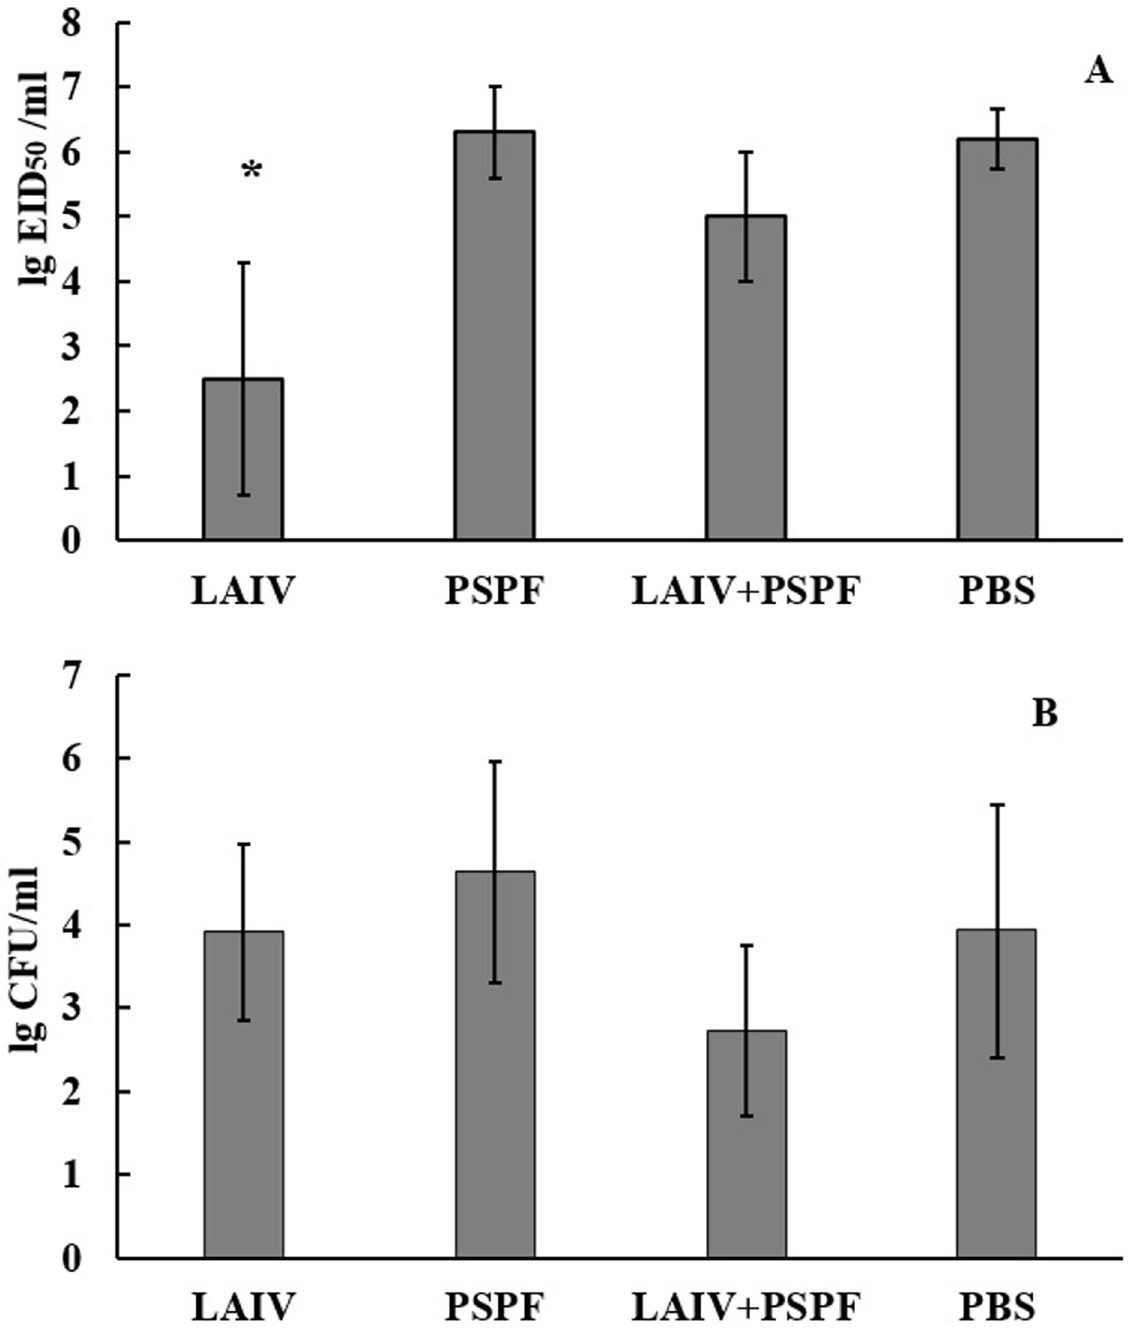
Fig 5. Virus (A) and S . pneumoniae (B) isolation from the lungs after sequential challenge with influenza virus followed by S . pneumoniae type 3 infection. Pathogens were isolated from lung homogenates (n = 6) obtained at 48 hours post viral infection. Bacterial and viral counts were characterized as log10 and presented as mean ± SD; � -significantly different values (p � 0.05) in comparison to mock-immunized animals (PBS).